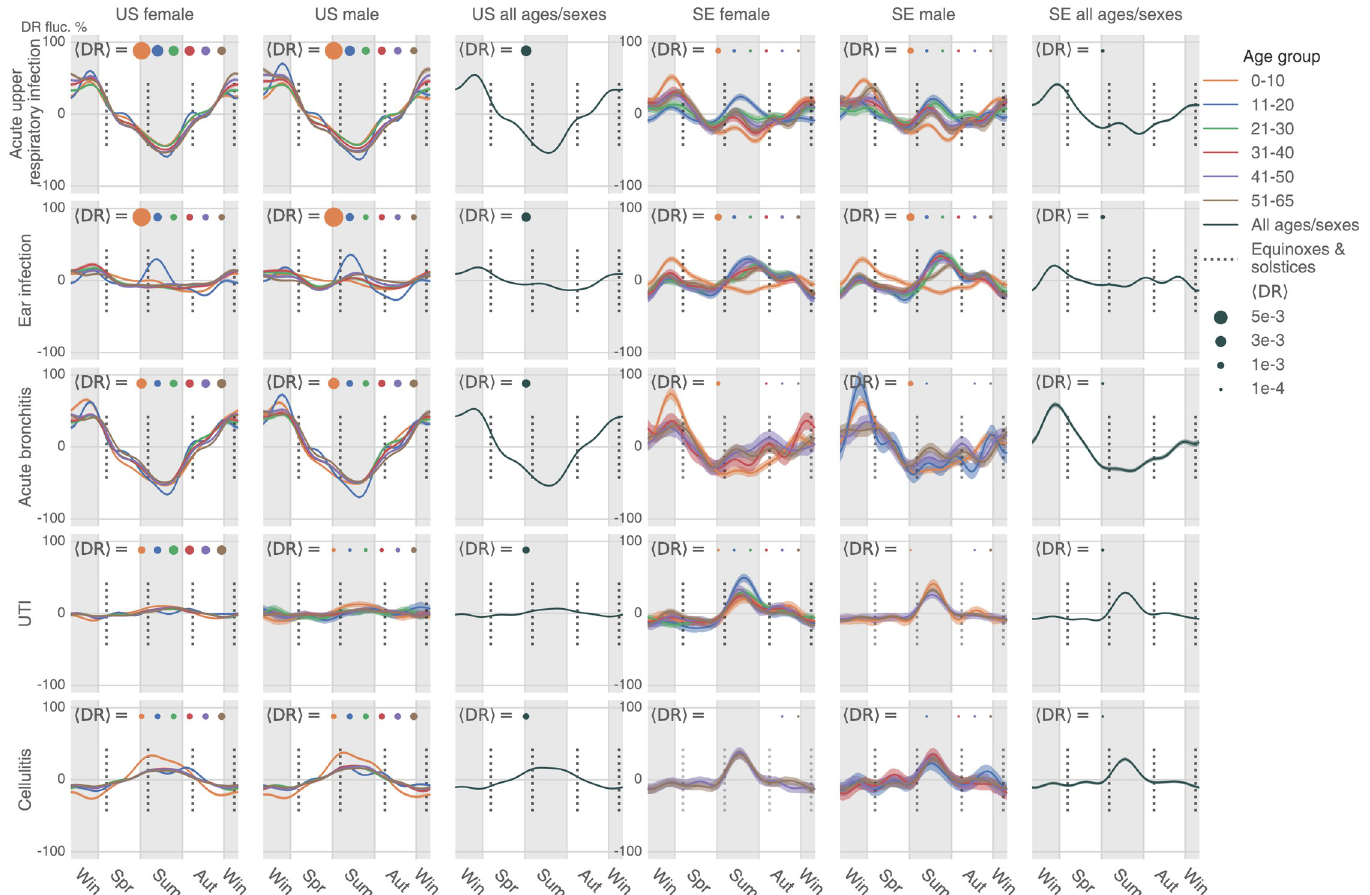
Fig 7. The corrected seasonality plots of the 5 most diagnosed infectious diseases in the US and SE: acute upper respiratory infection, ear infection, acute bronchitis, UTI, and cellulitis. The data underlying this figure can be found in https://doi.org/10.5061/dryad.vdncjsxv6. DR, diagnosis rate; SE, Sweden; UTI, urinary tract